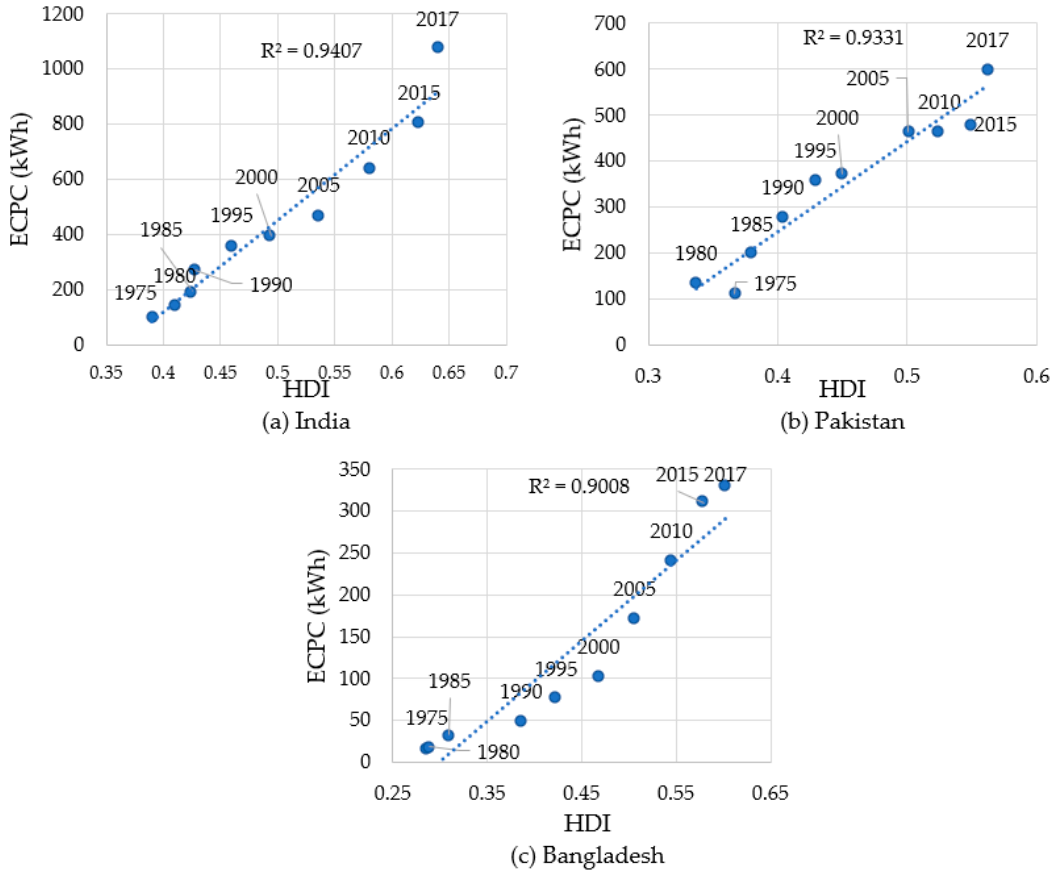
Figure 23. ECPC vs. HDI showing a linear relationship for each of IPB countries.